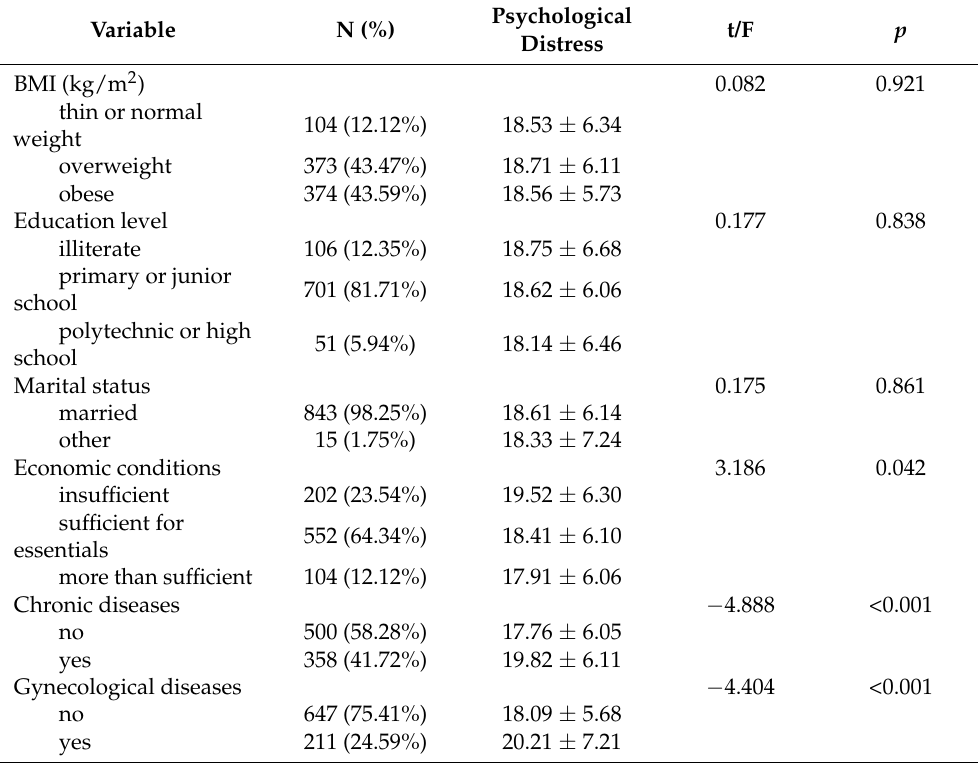
Table 1. Differences in sociodemographic and clinical characteristics of 858 women during MT in terms of psychological distress ( n =